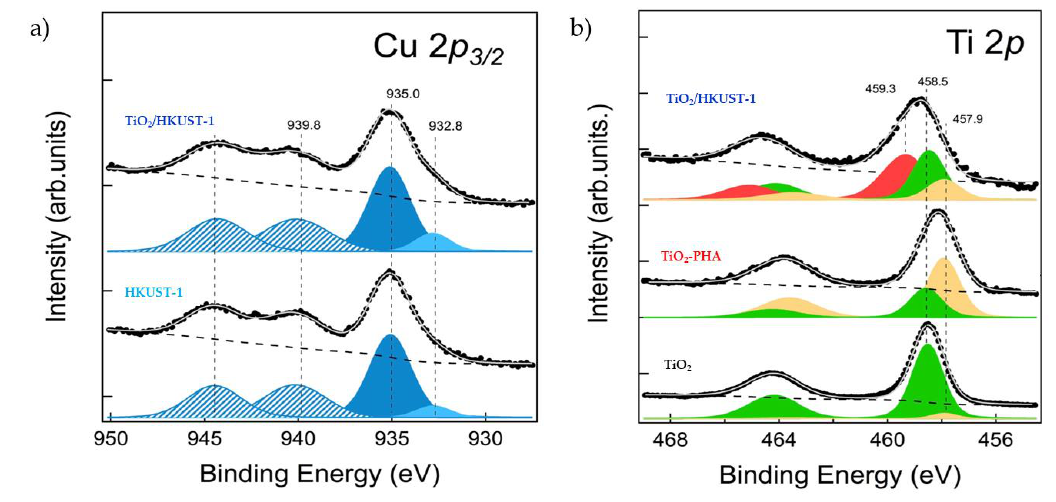
Figure 7. XPS spectra of ( a ) Cu 2 p 3/2 in bare HKUST-1 and TiO 2 /HKUST-1 [experimental data (dotted line), Cu(I) (sky blue peak), Cu(II) (blue peak) and its satellites (striped peaks)]; ( b ) Ti 2 p in bare TiO 2 , TiO 2 -PHA and TiO 2 /HKUST-1 [experimental data (dotted line), Ti(IV) (green and red peak), Ti(III) (yellow